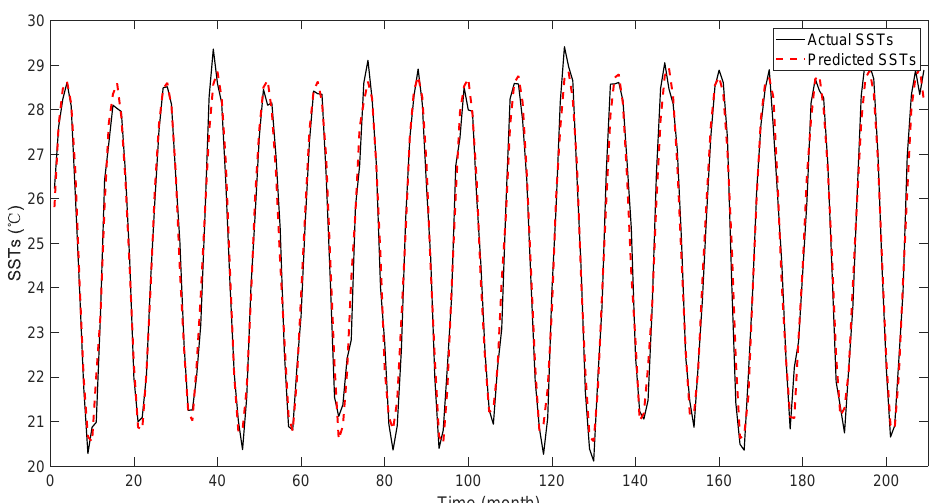
Figure 7. The predicted SSTs of the hybrid ARIMA-GABP model and the actual SSTs in the test set.